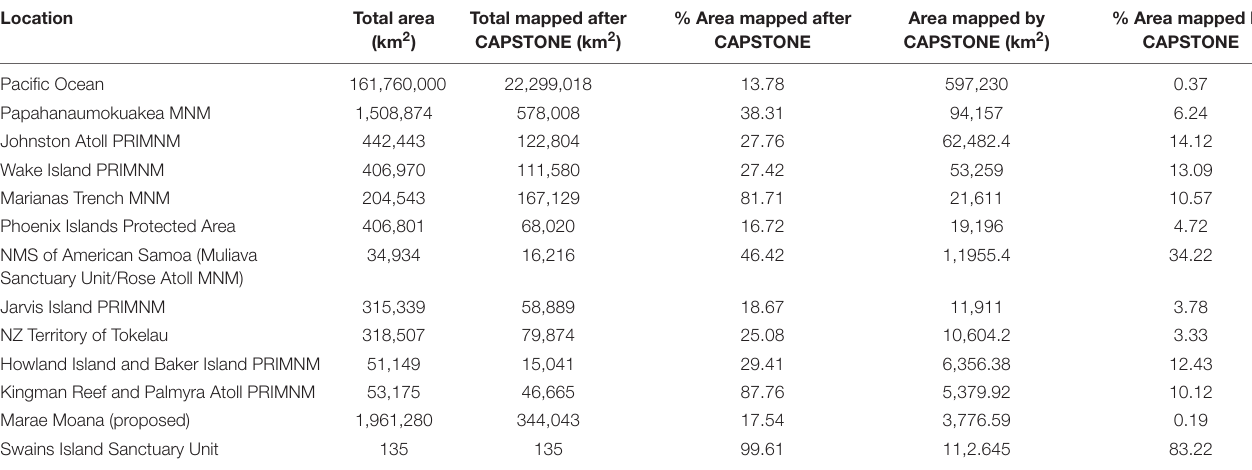
TABLE 2 | CAPSTONE multibeam mapping accomplishments after 3 years of effort by the Okeanos Explorer